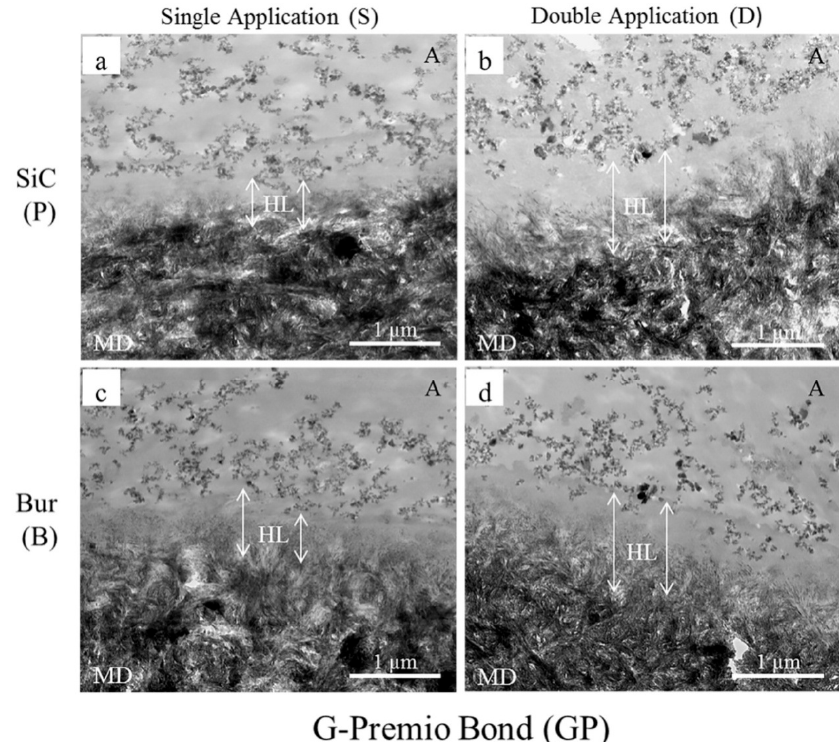
Figure 1. Representative TEM images (20,000 × ) of resin-dentin interfaces created by G-Premio Bond (GP) with 180-grit SiC paper-prepared ( a , b ) and fine-grit diamond bur-cut dentin ( c , d ) in single ( a , c ) and double application ( b , d ) modes. A represents an adhesive containing scattered nano-sized filler particles. The double-ended white arrows represent the extension of the hybrid layers (HL) from beneath the filler-containing adhesive layer until the electron-dense mineralized dentin (MD). The length of the arrows on either side of HL mark is different in bur-cut dentin, implying that the thicknesses are not uniform. The fillers could not get into the collagen webs of the HL, forming an electron-lucent, filler-free top part of the HL. Double applications ( b , d ) increased the thicknesses of the HL.